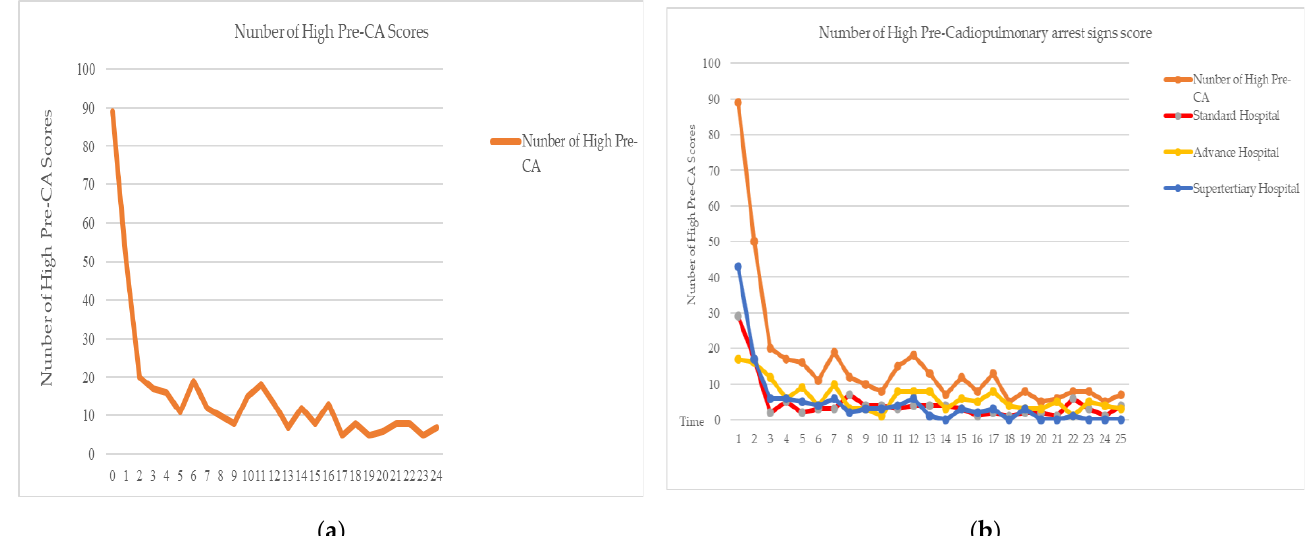
Figure 1. ( a ) Mean pre-cardiopulmonary arrest signs over time within 0 – 24 h. ( b ) The mean pre- cardiopulmonary arrest sign scores across time for three hospital levels. cardiopulmonary arrest sign scores across time for three hospital levels.